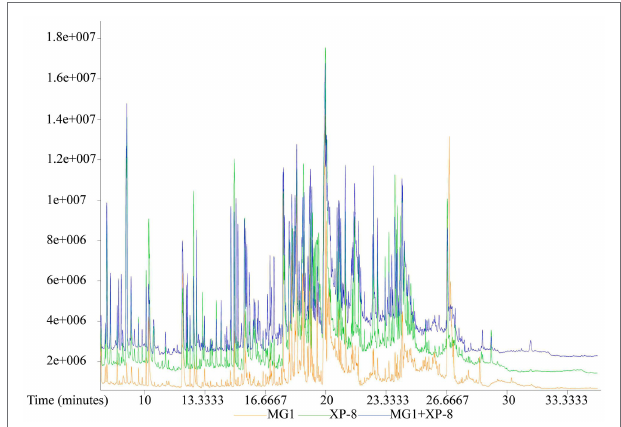
FIGURE 3 | Representative GC–MS TIC chromatograms of MG1 culture, co-culture (MG1 + XP-8), and XP-8